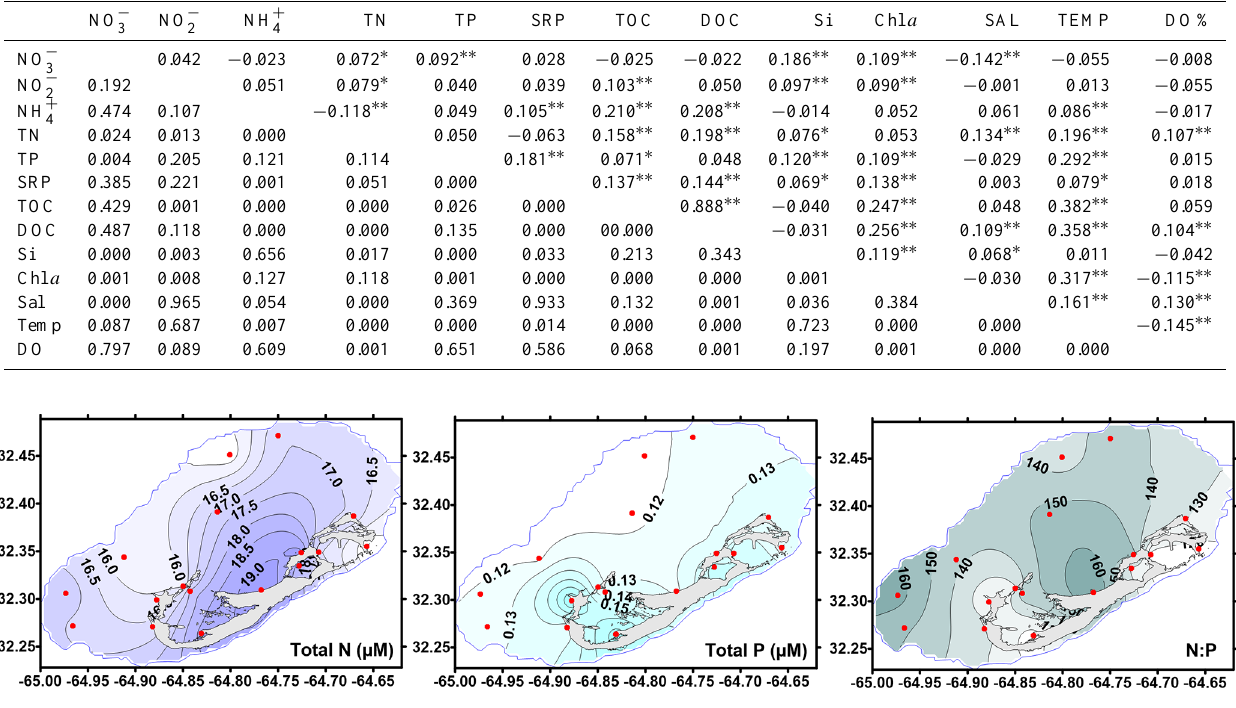
Figure 1. Isopleths of period-of-record averages for total nitrogen (TN; µM), total phosphorus (TP; µM) and the molar ratio of N:P in the water column on the Bermuda Platform. The blue lines are the 20m isobaths on the rim of the platform. Red dots indicate locations of the 17 permanent sampling